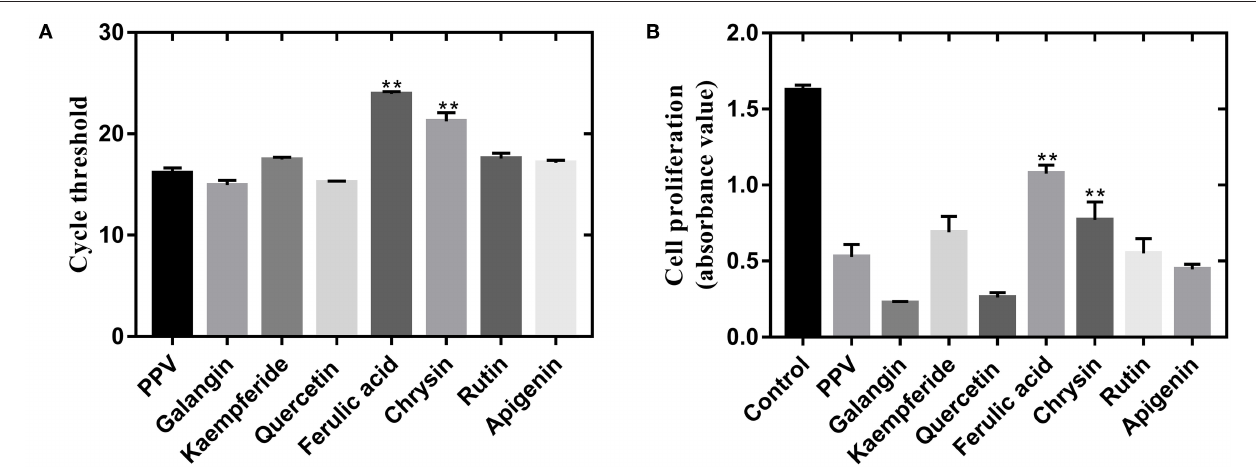
FIGURE 5 | PF isolated from propolis inhibited PPV-induced cell death of PK-15 cells. (A) Effect of PF treatment on PPV replication. Virus replication ability was detected by real-time polymerase chain reaction. (B) Cell proliferation of PPV-infected PK-15 cells after PF treatment. Cell proliferation was measured by CCK-8 assay. **There is a significant difference compared with PPV